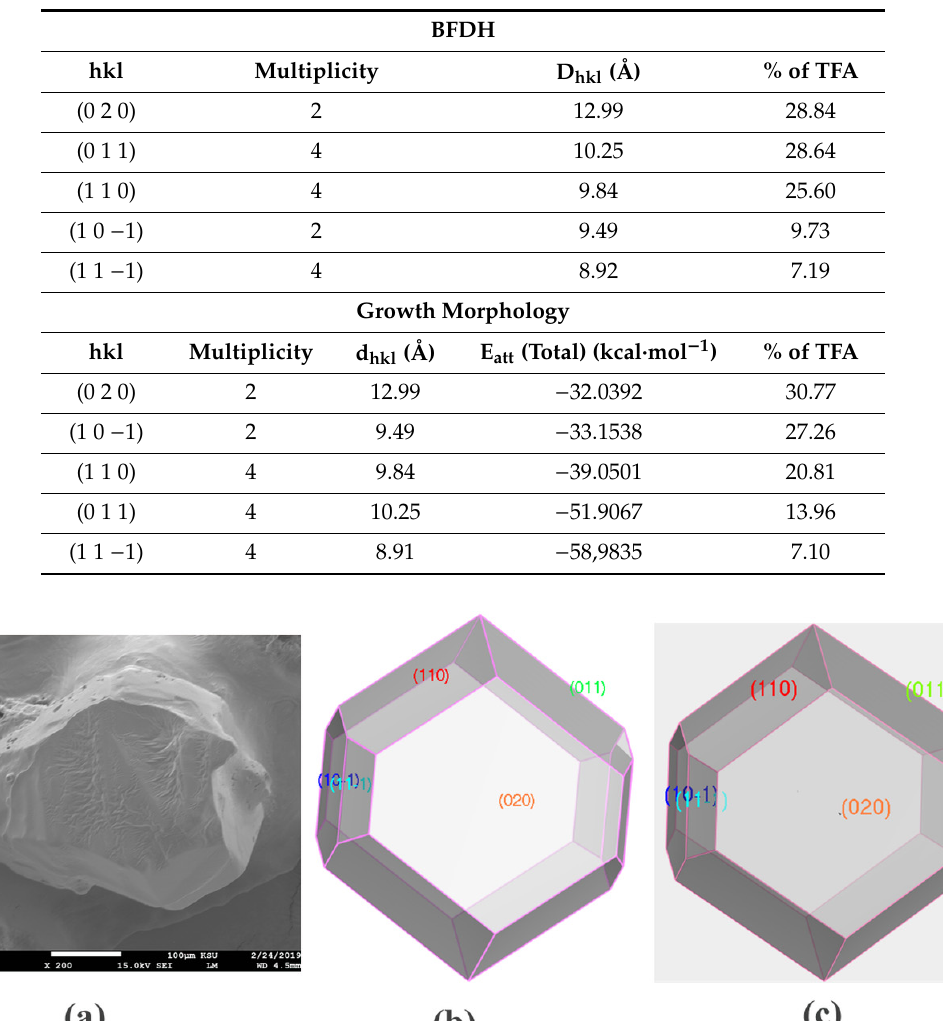
Table 5. Morphology predictions for Bi 4 I 16 · 4(C 6 H 9 N 2 ) · 2(H 2 O) through Bravais–Friedel, Donnay– Harker (BFDH) (upper) and growth morphology (GM) (lower) calculations. The percentage of total facet area (TFA) is calculated as 100 × (hkl facet area) / (total surface area). BFDH